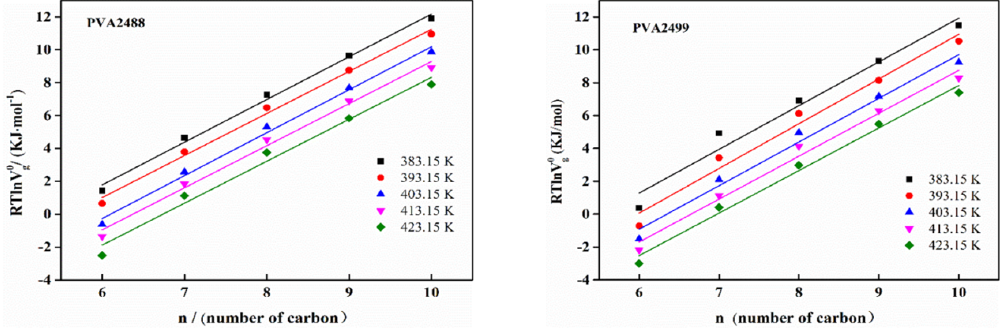
Figure 5. Variation of RTlnV (cid:2917) (cid:2868) with the number of carbon atoms of n-alkanes at different temperatures. Figure 5 plots the linear graph of RT ln V (cid:2917)(cid:2868) and the number of carbon atoms of n-alkanes corresponding to PVA. Its slope is Δ G . Substituting it into Equation (10) CH 2 can obtain the dispersion component γ (cid:2929) (cid:2914) of PVA. The lower the dispersion component (cid:2914) of PVA at 383.15–423.15 K, the more specific the value that can be obtained from Ta- γ (cid:2929) ble 8, and in conjunction with Figure 6, it can be seen directly that the dispersion com- ponent γ (cid:2929)(cid:2914) does not change significantly with the increase in temperature, indicating that the dispersion effect between the nonpolar probe and the PVA surface under the tem- perature gradient of 383.15–423.15 K is less affected by temperature, the γ (cid:2929)(cid:2914) value is rela- tively close and less sensitive to temperature. This is most likely due to the too high temperature, which makes a certain degree of deformation on the PVA surface, so that the surface dispersion force is not only affected by the nonpolar functional groups. It may also have some relationship with the surface roughness of PVA, but due to the complexity of the situation, a more regular γ (cid:2929)(cid:2914) cannot be obtained, so the dispersion component γ (cid:2929)(cid:2914) of PVA at room temperature cannot be obtained by extrapolation. Com- paring the γ (cid:2929)(cid:2914) of PVA2488 and PVA2499, PVA2499 has a higher γ (cid:2929)(cid:2914) at the same temper- ature. 3.4.2. Specific Component γ (cid:2929)(cid:2929)(cid:2926) and Total Surface Energy γ (cid:2929) The surface-specific component γ ssp reflects the surface energy of the dispersive part between the filler and the probe, which includes polarity, acid–base, and hydrogen bonding. It can be calculated by the Good–van Oss method [42] combined with the spe- cific adsorption free energy Δ G sp . The formula is as follows: ΔG sp = 2Na((γ (cid:2922)(cid:2878) γ (cid:2929)(cid:2879) ) (cid:2869)/(cid:2870) (cid:3397) (γ (cid:2922)(cid:2879) γ (cid:2929)(cid:2878) ) (cid:2869)/(cid:2870) )